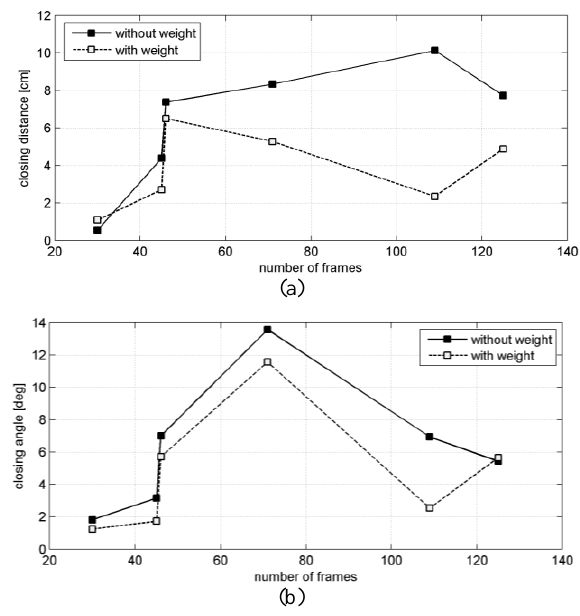
Figure 6. Example point clouds of an office environment obtained by weighted registration of RGB-D